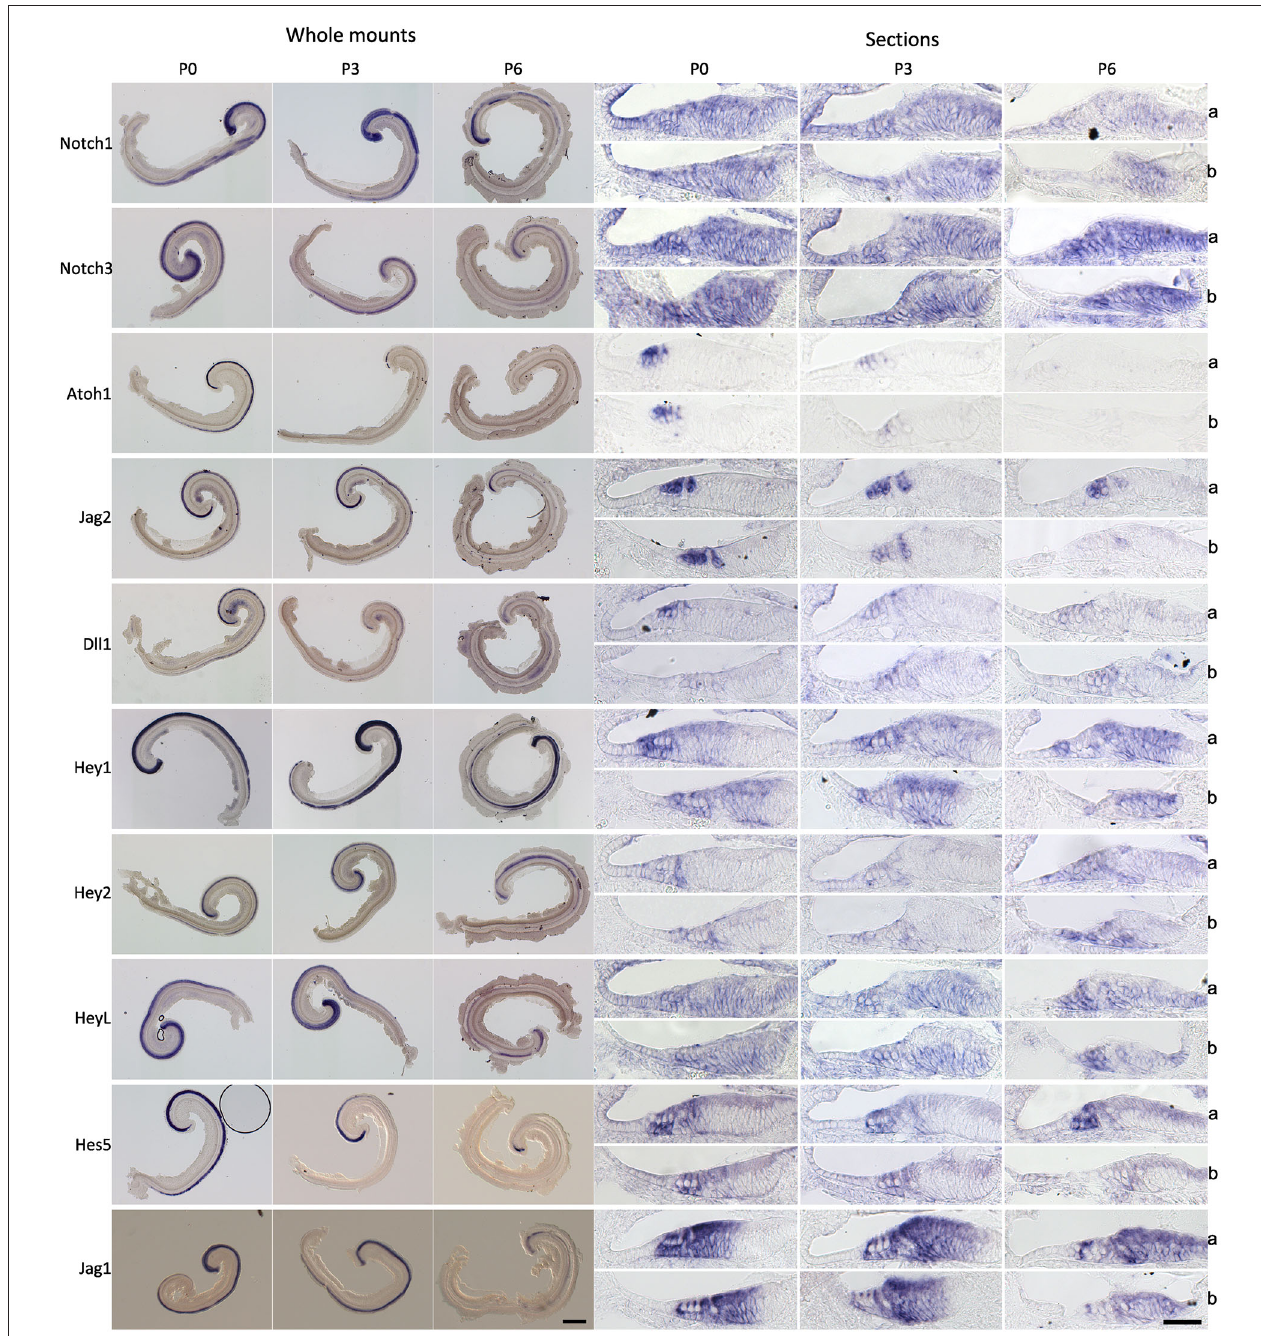
in situs of cochlear explants, with the samples curved clockwise from apex to base. Scale = 200 µ m. Right panels: In situ hybridization of frozen sections; a: apex region, b: basal region. Scale 50 µ